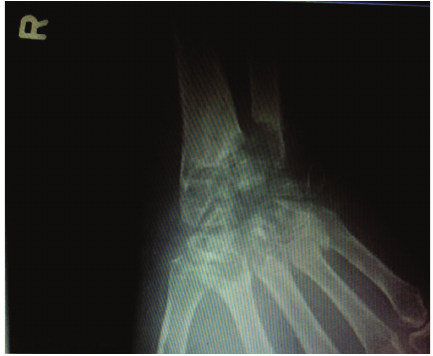
Figure 1: X-ray anteroposterior view of wrist joint: septic arthritis of distal radius/ulna, carpal bones, and bases of